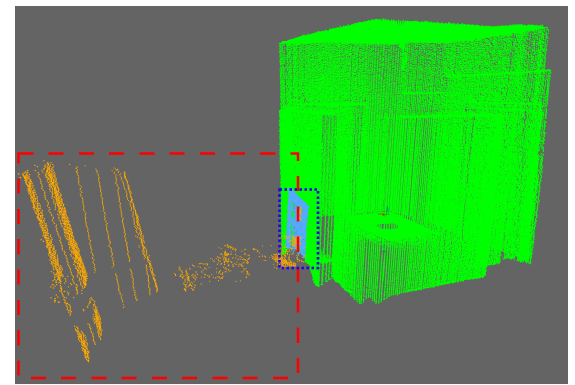
Figure 5: Cleaned scan after the 3D-Mirror-Detector-Pre-Filter was applied. Green colored are valid points, turquoise colored are points on the mirror plane, and orange are points behind the mirror plane Figure 6 shows the mirror points (turquoise) and the erroneous points (orange) from the side. Therefore, it is possible to see the ”thickness” of the mirror which depends on the chosen threshold d thres (see Equation